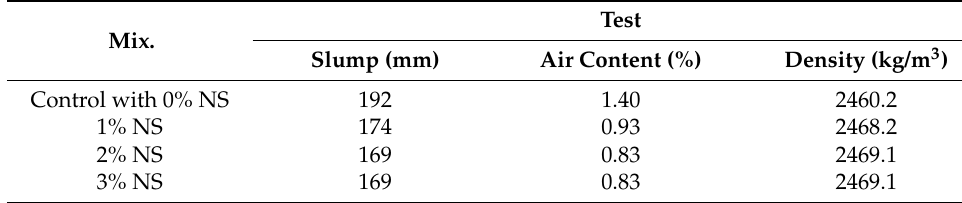
Table 3. Slump air content and density of concrete mixtures.